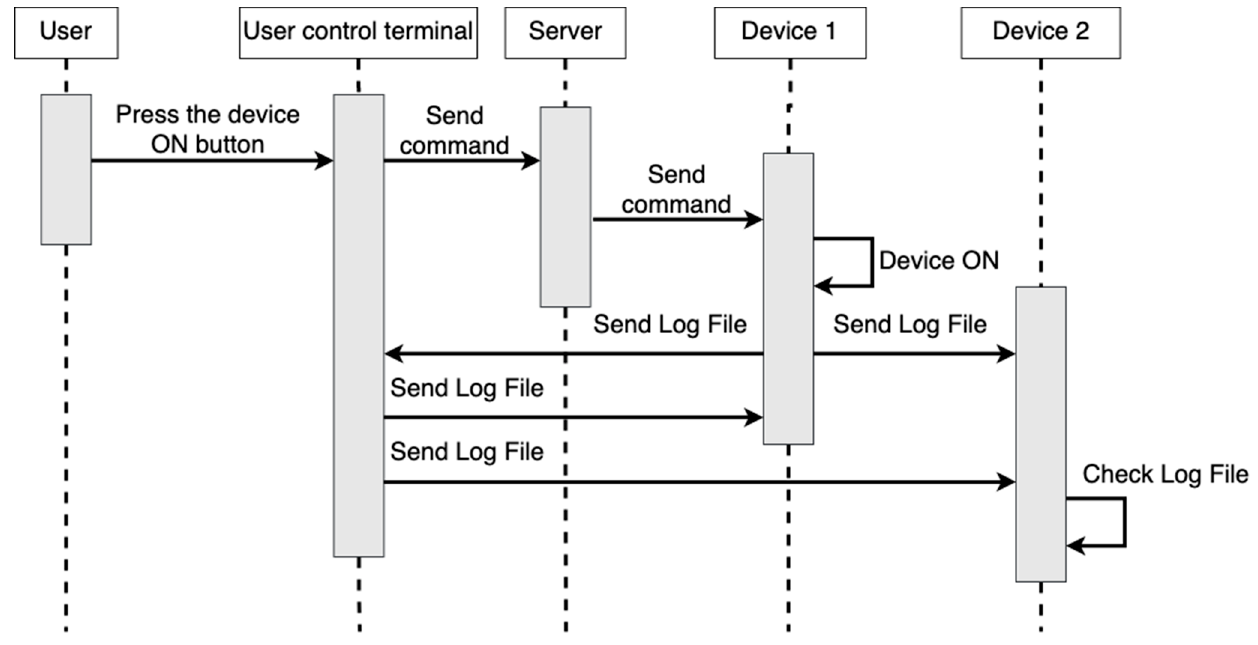
Figure 14. Sequence diagram of user control equipment.